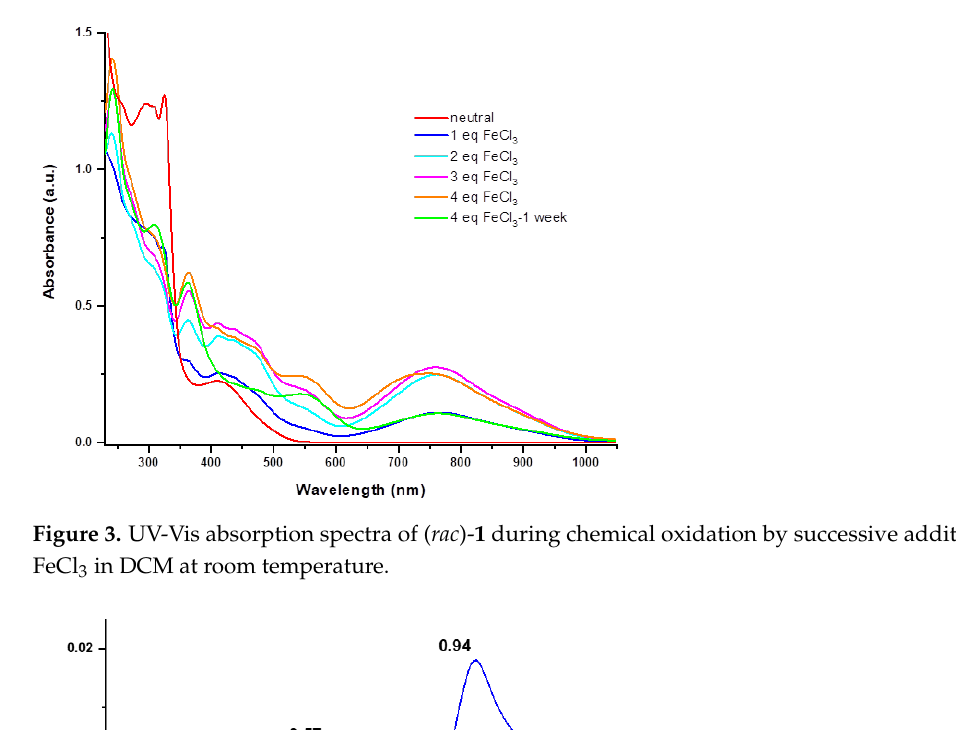
Figure 3. UV-Vis absorption spectra of ( rac )- 1 during chemical oxidation by successive addition of FeCl 3 in DCM at room temperature.